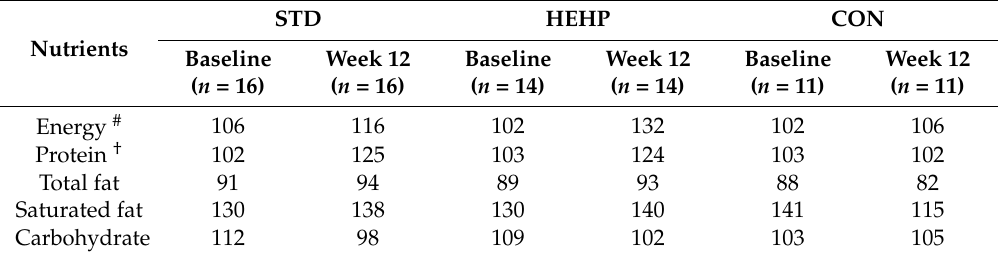
Table 3. Percentage of Recommended Dietary Intake achieved at baseline and week 12 STD, HEHP and CON ˆ